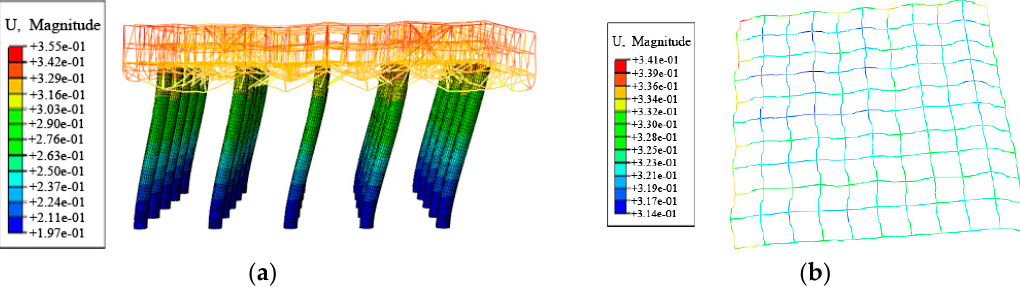
Figure 10. Lateral deformation nephograms of the structure under the rare earthquake (PGA (Peak ground acceleration) = 0.40 g): ( a ) Whole structure; ( b ) steel solid web girder platform.